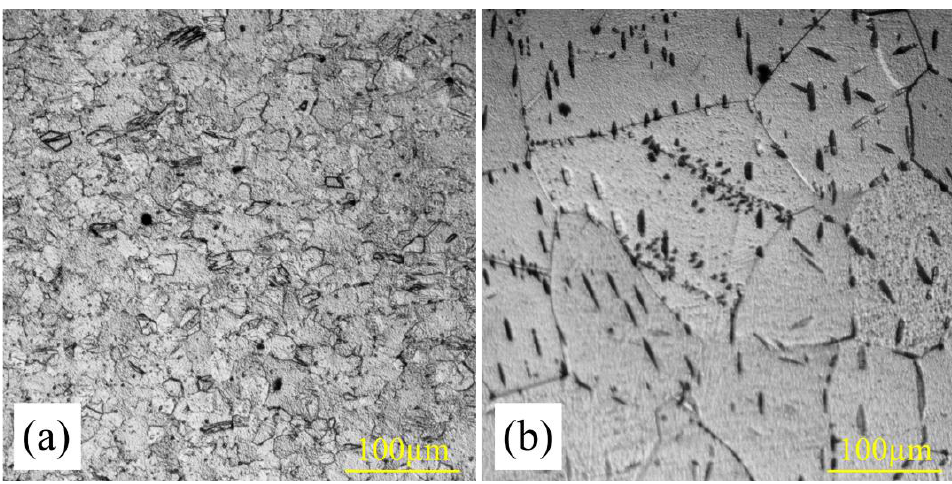
Figure 4. Optical micrograph of the cross-section of Ti sheet ( a ) as received without any pre-annealing process and ( b ) annealed at 1033 K for 150 min.